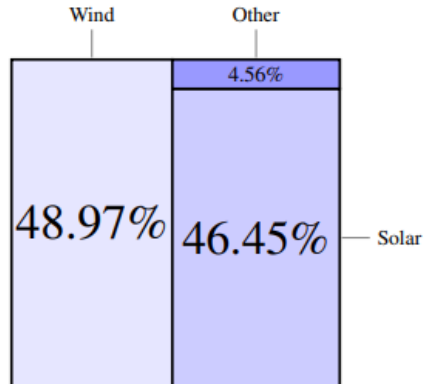
Figure 3. Cumulative installed renewable power capacity mix in 2020 (own representation with information from [33]).